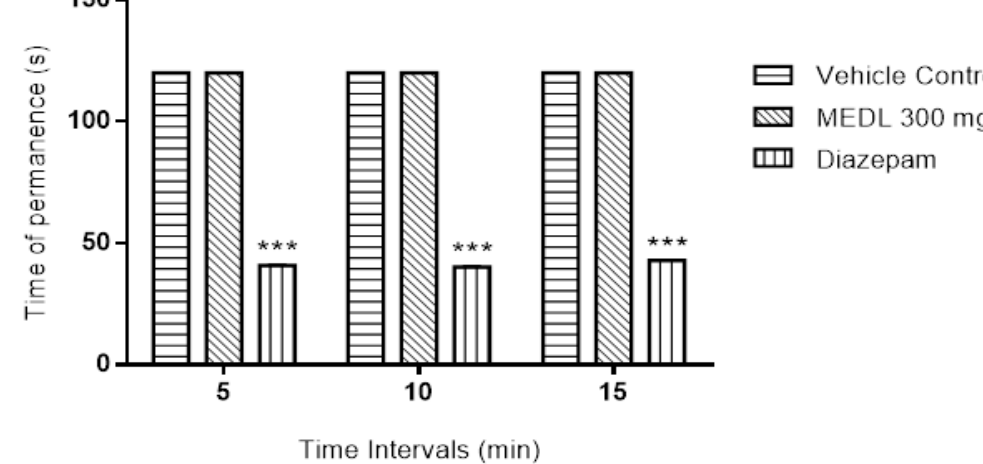
Figure 3. E ff ect of MEDL on Rota–rod test in mice. Each column represents the mean ± SEM of six mice. Statistical analyses were performed using 2-way ANOVA followed by Tukey’s multiple comparisons test. *** p < 0.001 compared to vehicle control group.